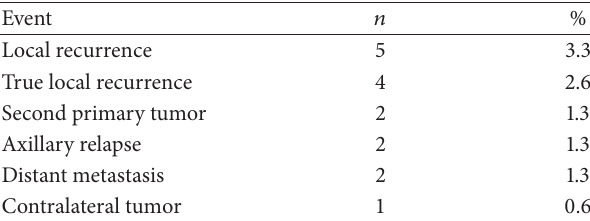
Table 2: Incidence of first unfavorable events.